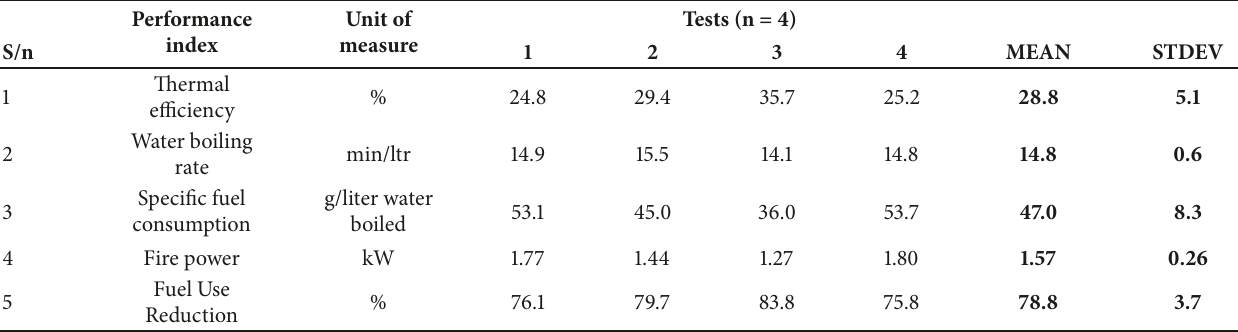
Table 4: Summary of results on thermal performance of the